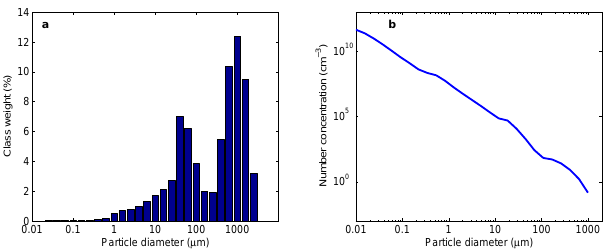
Figure 2. (a) Typical distal ash-fall particle size analysis from Rose and Durant (2009) and (b) particle number concentration calculated based on the same data.